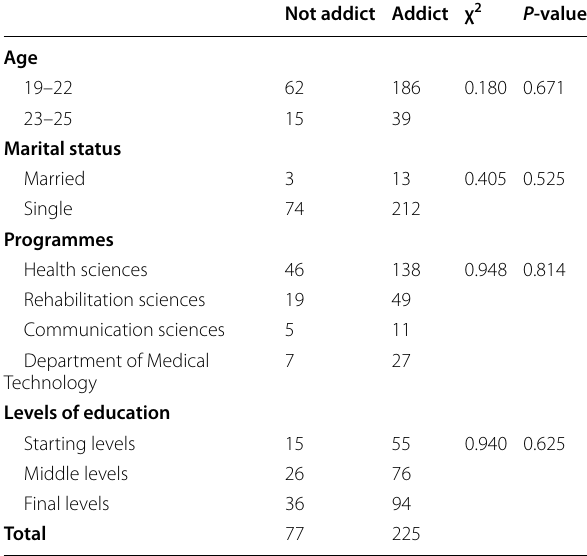
Table 4 Relationship between social media addiction and the characteristics of study